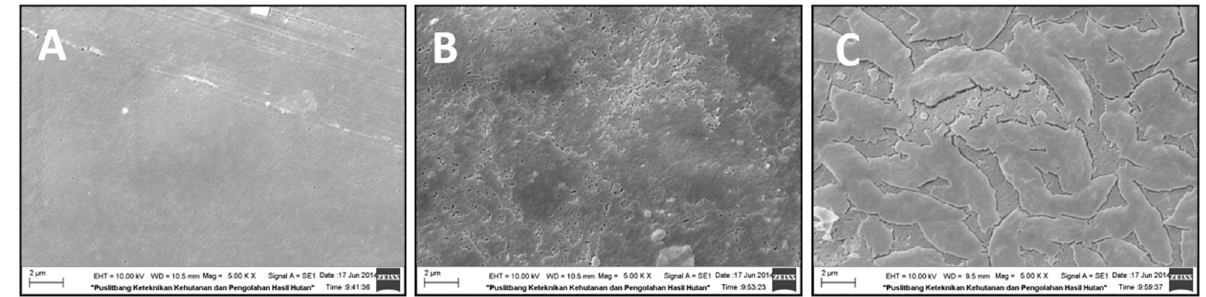
Figure 3. SEM Surface morphology: ( A ) control chitosan films; ( B ) biohybrid nanocomposite films made of chitosan+1%ZnO-NPs without SA; ( C ) biohybrid nanocomposite films made of chitosan+1%ZnO-NPs with 5%SA.